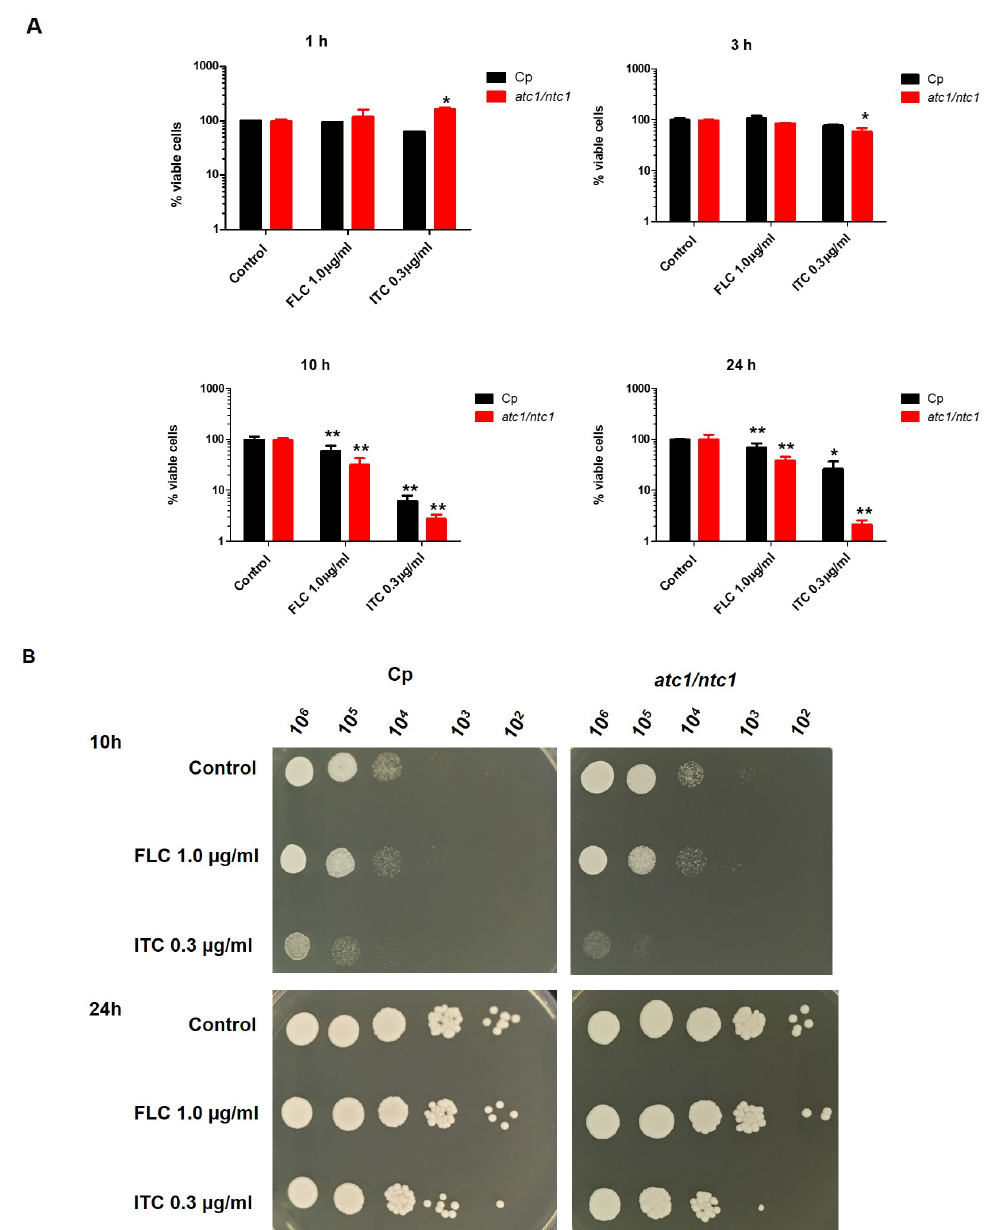
Figure 1. Time-course effect of FLC and ITC on cell survival recorded in the parental strain of C. parapsilosis ( Cp ) and the trehalase-deficient null mutant atc1 ∆ /ntc1 ∆ . YPD-grown cultures of the two strains were exposed to the indicated doses of antifungals and incubated at 37 ◦ C. Identical samples (10 7 cells/mL) were harvested at the indicated times. ( A ) Viability in liquid medium was determined after appropriate dilution with sterile water by plating in triplicate on solid YPD and incubating for 2–3 days at 37 ◦ C. A control sample was left without treatment (100% viabilily). The experiment was repeated twice with similar results, and the values shown are the mean ± standard deviation of three independent determinations. The difference between the mean values obtained was statistically significant at p < (0.05) (*), p < (0.01) (**) according to the Mann–Whitney range test. ( B ) Ten-fold cell suspensions containing the specific compound were spotted (5 µ L) on YPD plates, which were scored after 48